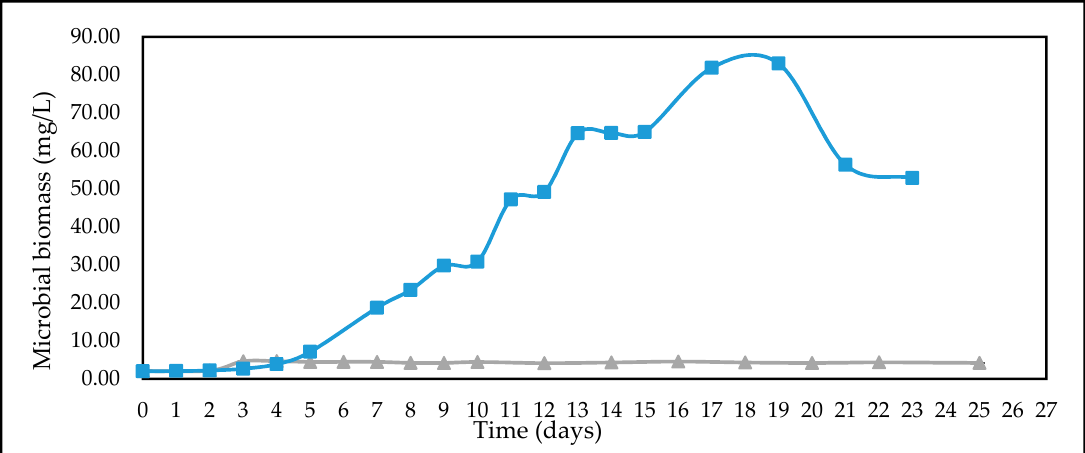
Figure 1. Growth of A. woodii (microbial biomass in mg/L) on 10 g/L glucose ( (cid:4) ) and 10 g/L xylose ( (cid:78) ) (all standard deviations were less than 5% and cannot be seen in the graph).